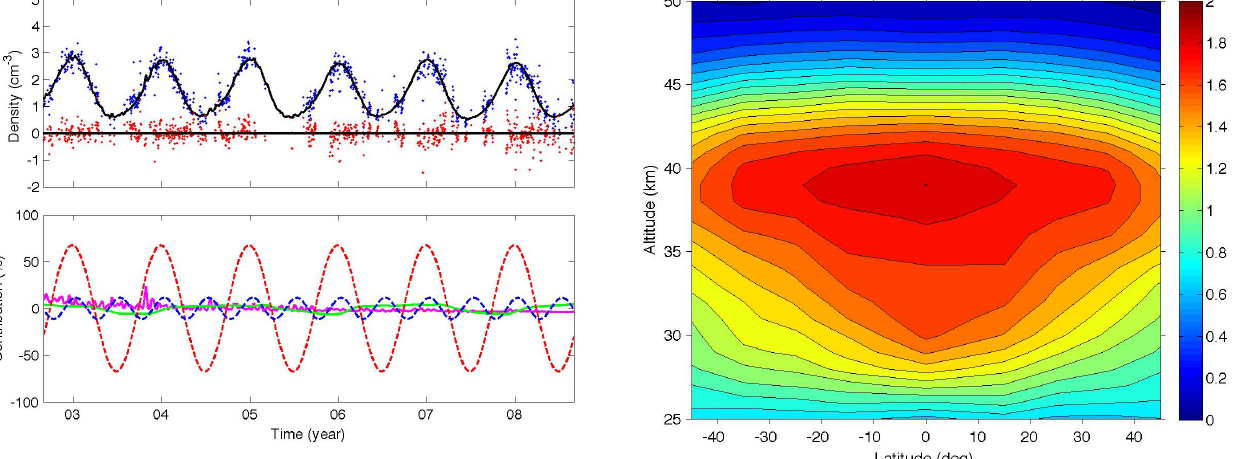
Fig. 25. The NO 3 constant term c(z) of the time series as a function of latitude and altitude. The scale is 10 7 cm − 3 .